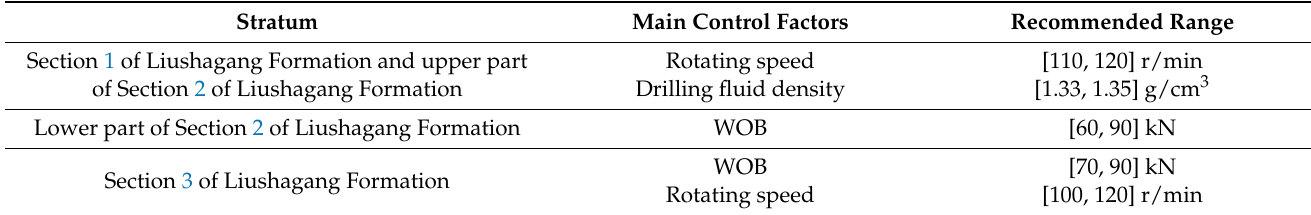
Table 1. Recommended range of main control factors of ROP.